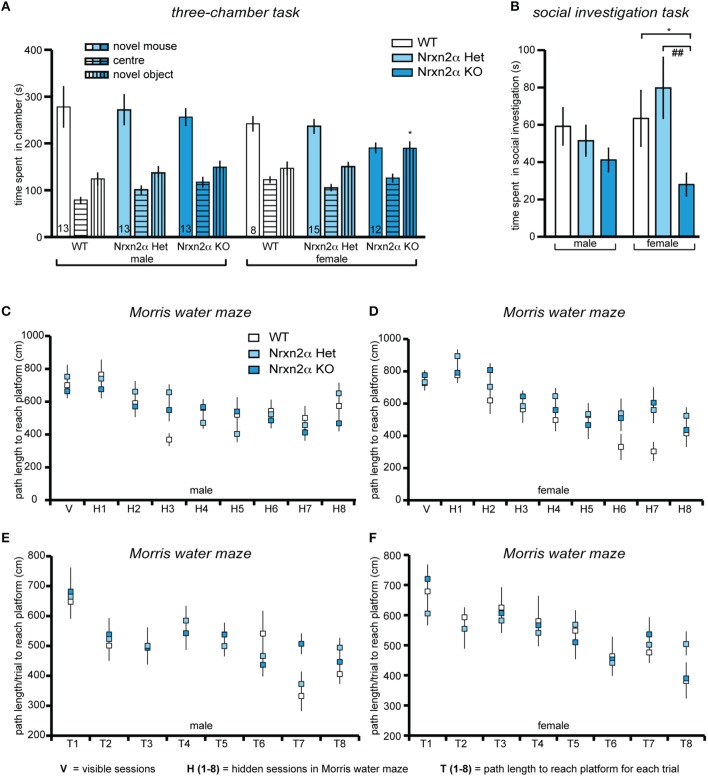
Deletion of Nrxn2α in mice impaires social interaction behaviors. Behavioral analysis of Nrxn2α KO mice in the three-chamber social approach task (A), social investigation task (B), Morris water maze (C,D) and delayed matching-to-place task (E,F). (A) Time (s) spent in the chambers containing the novel object or the conspecific mouse, and the center chamber during trial 2 of the three-chamber social approach task. (B) Time (s) spent socially investigating the conspecific during the social investigation task. (C, D) Path length (cm) taken to reach the platform across the visible (V) and hidden (H1 to H9) sessions in the Morris water maze, for male and female mice respectively. (E, F) Path length (cm) taken to reach the platform for each trial (T1–T8) averaged across each of the seven sessions, during the delayed matching-to-place task, for male and female mice respectively. Data shown are mean (± SEM) and derived from 17 WT (white bars, 9♂, 8♀), 28 HET (light blue bars, 13♂, 15♀), and 25 Nrxn2α KO mice (blue squares, 13♂, 12♀); level of significance indicated by *p < 0.05, compared to WT and ##p < 0.01, compared to HET.